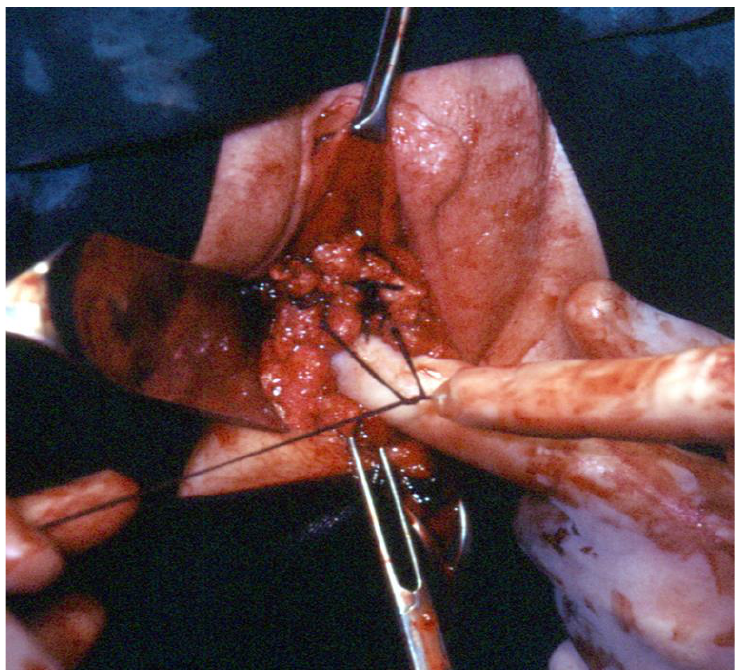
Figure 7. On the left, the Heaney clamp grasps the round and Utero-Ovarian ligaments and Fallo- pian Tubes; in the center, cutting the clamped tissues; on the right, ligation of the dissected tissues. 8. Repairing prolapse, if exists, while leaving peritoneum unsutured; 9. Reconstruction of the pelvic floor by ligating both sides Sacro-Uterine and Paracer- vical stumps (Figure 8);